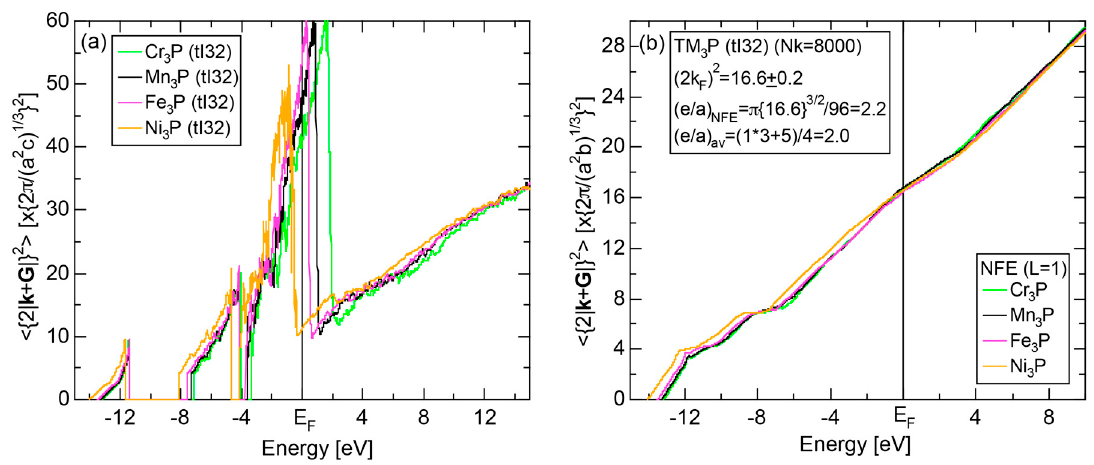
Figure 86. ( a ) Hume-Rothery plots and ( b ) the NFE ( L = 1) curves for TM 3 P (TM = Cr, Mn, Fe, and Ni) (tI32) compounds [12].